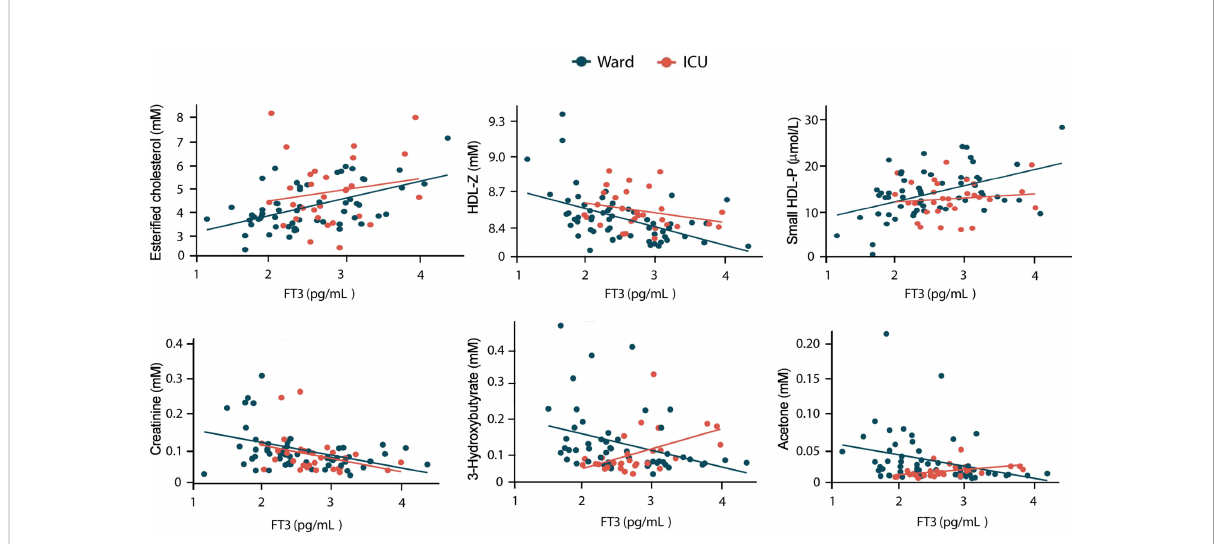
FIGURE 4 Correlation of metabolomic parameters with FT3 levels in hospitalized COVID-19 patients. Univariate linear regression analysis of the indicated metabolomic parameters in ward and ICU patient is